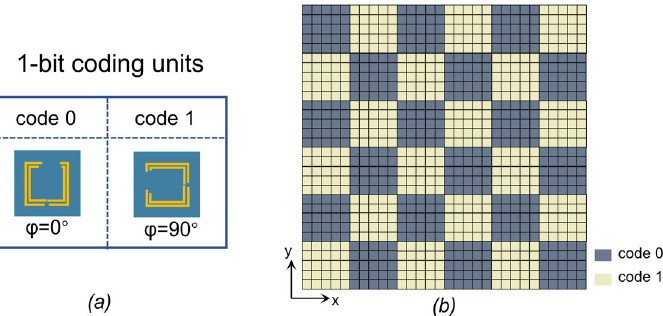
Figure 6. 1 ‐ bit coding scheme of the four ‐ beam splitting metasurface. ( a ) Two basic 1 ‐ bit coding units; ( b ) Chessboard coding strategy.